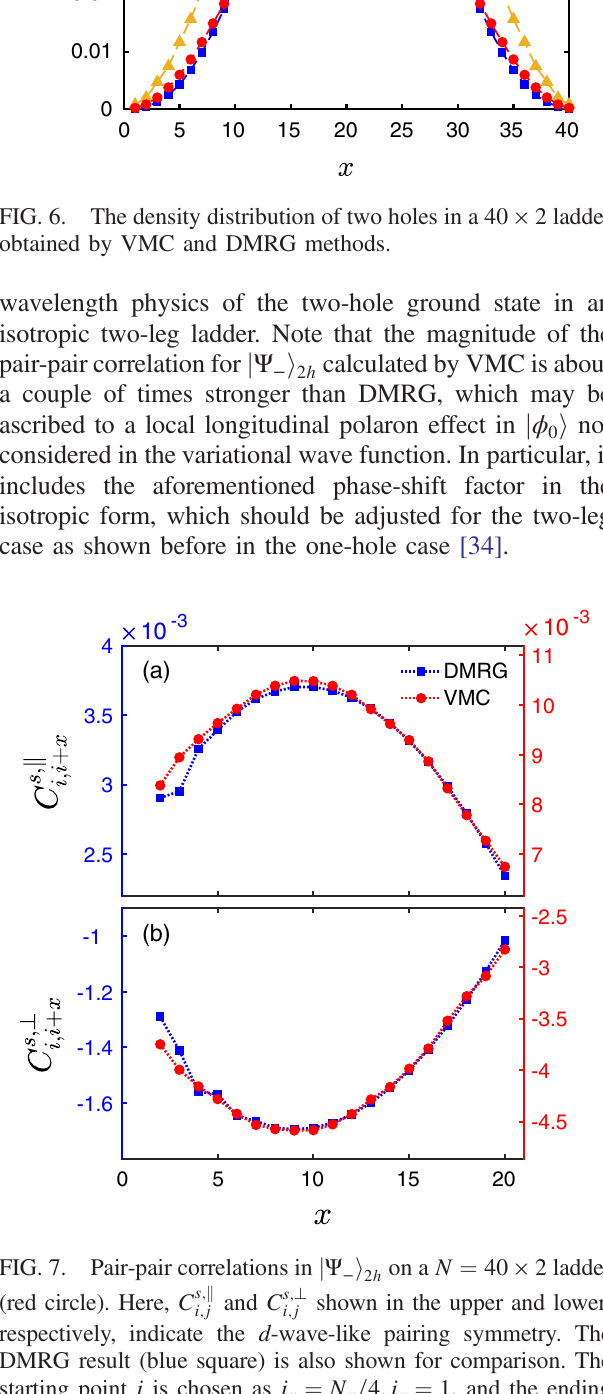
FIG. 7. Pair-pair correlations in j Ψ − i 2 on a N ¼ 40 × 2 ladder h and C s; ⊥ shown in the upper and lower, (red circle). Here, C s; k i;j i;j respectively, indicate the d -wave-like pairing symmetry. The DMRG result (blue square) is also shown for comparison. The 1 , and the ending N = 4 ; i starting point i is chosen as i x ¼ x y ¼ 1 . i x; j point is at j x ¼ x þ y ¼